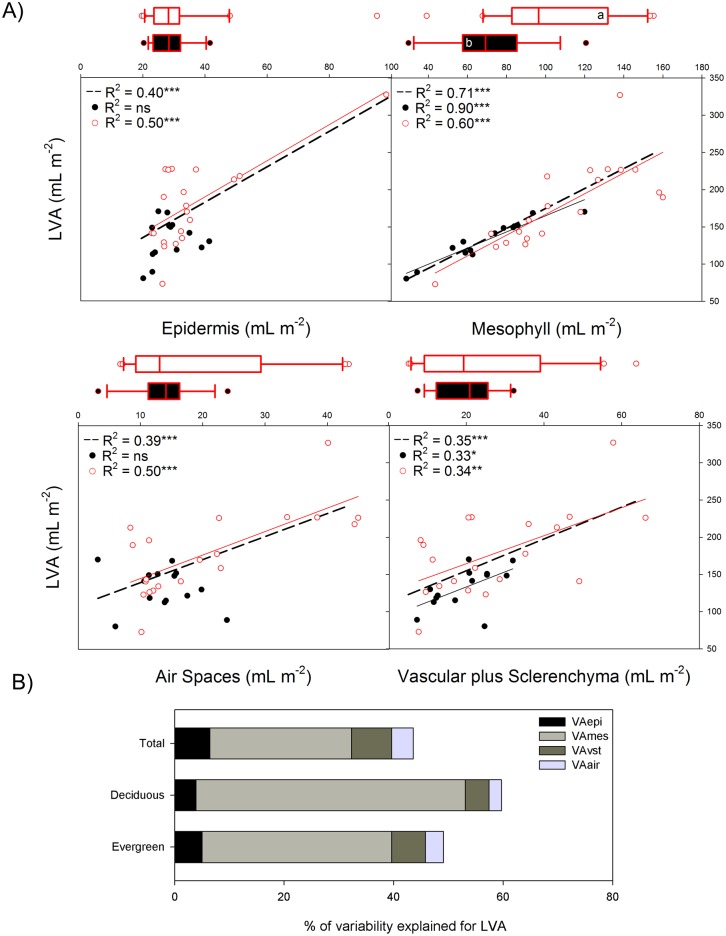
A) Linear regressions of leaf volume per area (LVA or thickness) with anatomical tissues, for deciduous species (dark line and circles), evergreens (red line and empty red circles) and all the species (dashed line). In brackets the slopes of the regression lines are given. The level of significance is expressed as follows: * P < 0.05, ** P < 0.01, *** P < 0.001. Box plots (median and 1st and 3rd quartiles) of deciduous vs. evergreen species are included in the margins; the significant results are based on the phylogenetic generalised least squares model (PGLS). The results based on PGLS can be found in S3 Table, Supporting Information. Whiskers show the minimum and maximum values that fall within 1.5x the length of the box away from the interquartile range; data further away are shown as outliers. B) Decomposition of the total variability explained by anatomical tissues, without covariations.